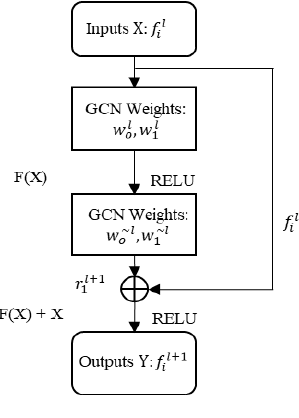
Figure 4.2: GCN: Residual